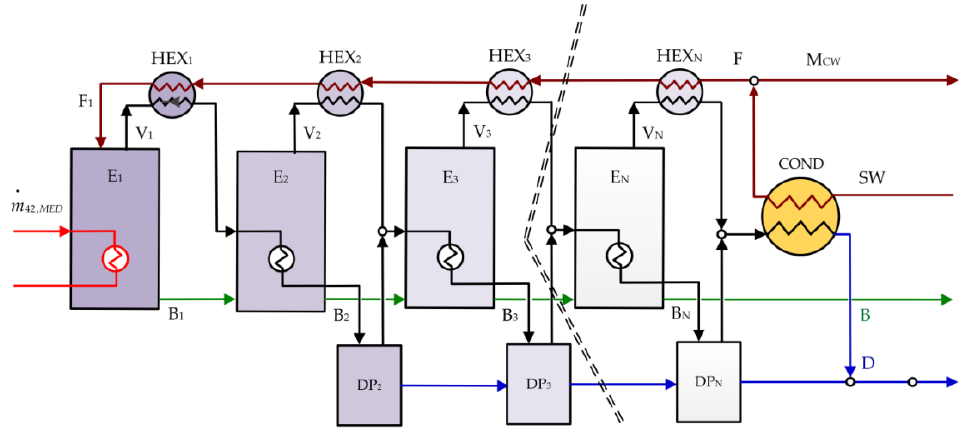
Figure A2. Schematic of a multi-effect distillation (MED) desalination process.